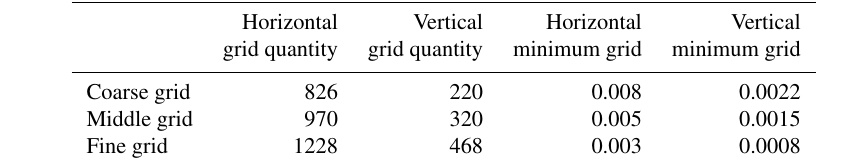
Table 2. Parameter of three sets of grids (Unit: m).